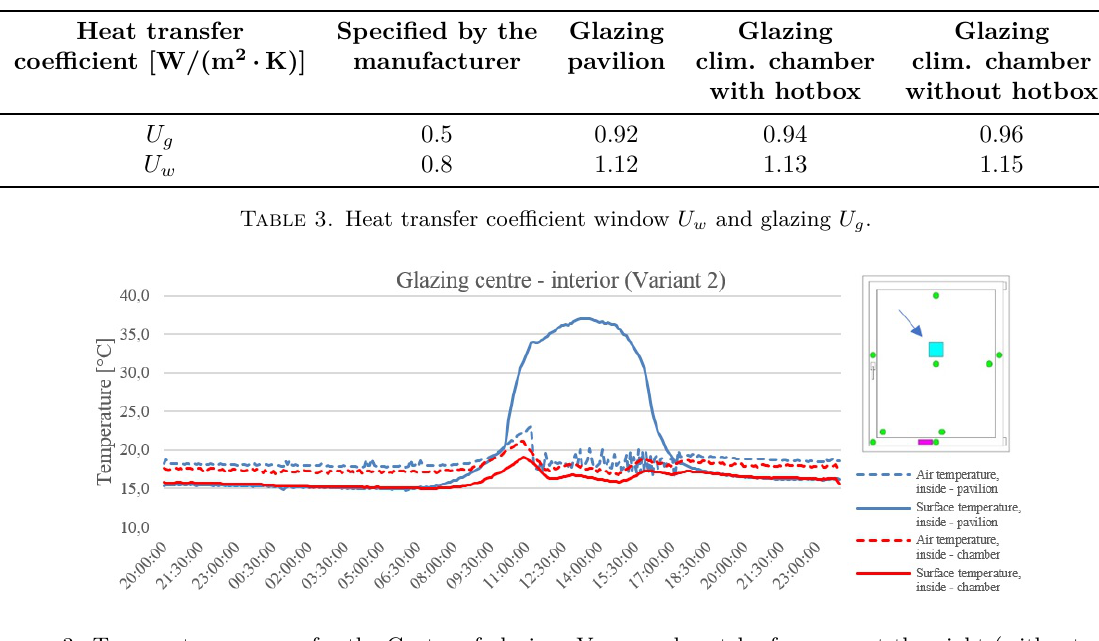
Figure 3. Temperature courses for the Centre of glazing. Very good match of courses at the night (without solar